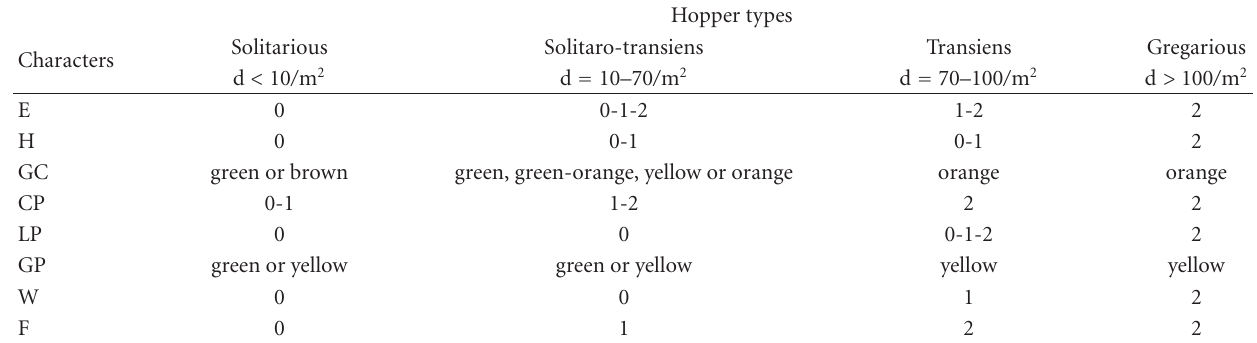
Table 1: Color characteristics of the four hopper